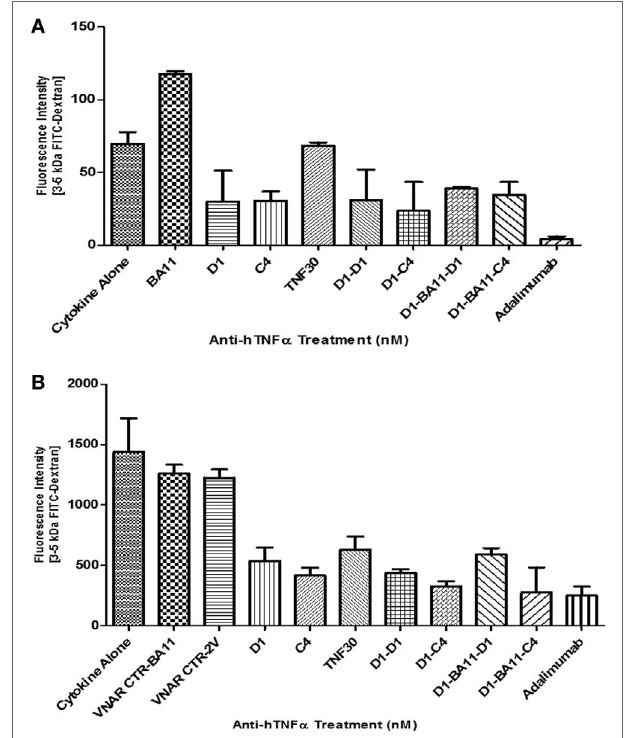
FigUre 7 | Efficacy of anti-hTNF- α variable new antigen receptors (VNARs) in preventing FITC-dextran paracellular flux in Caco-2 cell model of cytokine induced intestinal barrier dysfunction. All VNAR monomers were added at a final concentration of 50 nM while multivalent domains and adalimumab were added at a final concentration of 25 nM. FITC-Dextran flux was measured by taking media from the basolateral chamber at 2 h (a) and 24 h (B) post-addition of FITC-Dextran (i.e., 20 and 42 h post cytokine ± anti-TNF- treatment, respectively). Results shown are the mean ± SD ( n = 1) with four replicates per experiment, and all treatment groups have been corrected for the fluorescence intensity measured in untreated cells. y -Axis on both bar charts are on different scales. VNAR 2V is an isotype control isolated from a naïve library, and has no inherent affinity for any known target antigen (33, 40). VNAR BA11 has been described elsewhere in this paper.